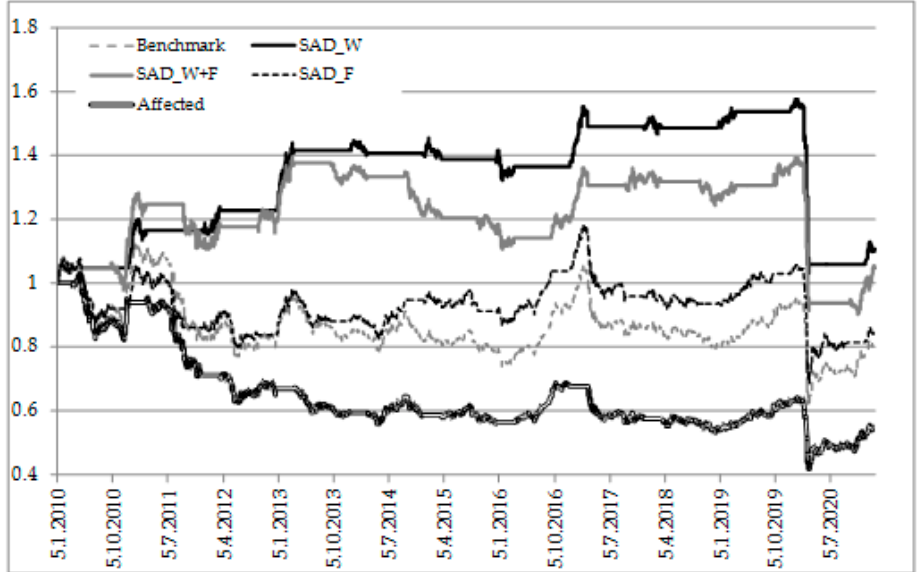
Figure 1. Values of simulated portfolio values.